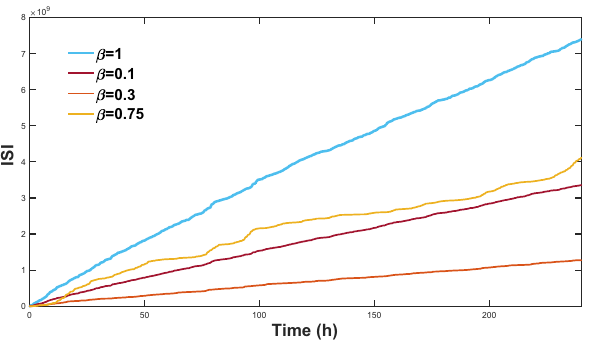
Figure 10: Comparison ISI error criteria of the four di ff erent con - trollers with a change in the β controllers with a change in the β .